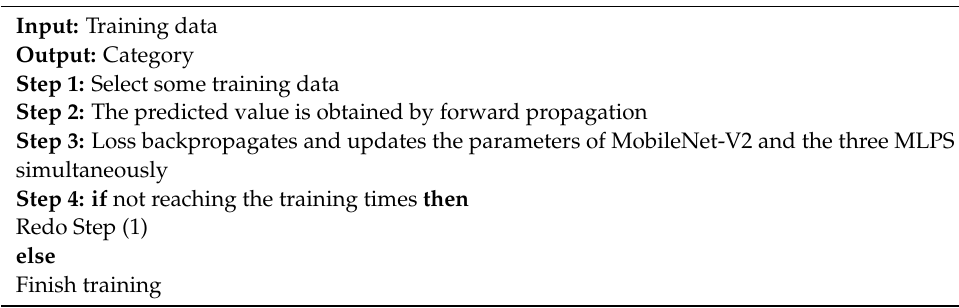
Algorithm 1 The fusion network training